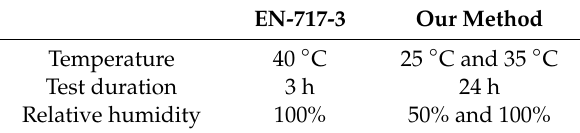
Table 2. Summary of modifications to EN-717-3.